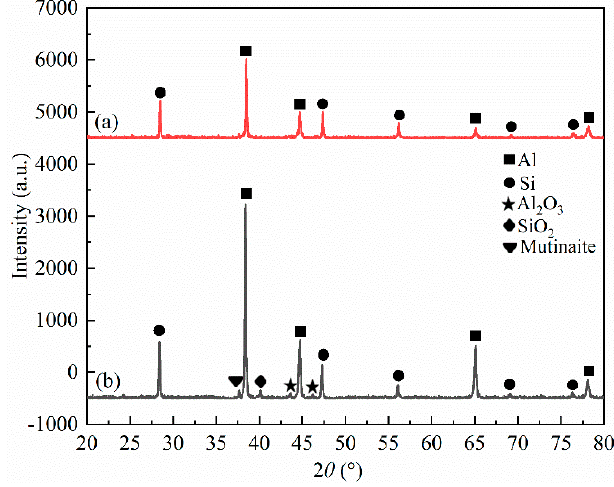
Figure 4. XRD for ZL109 ( a ) before; ( b ) after anodizing.